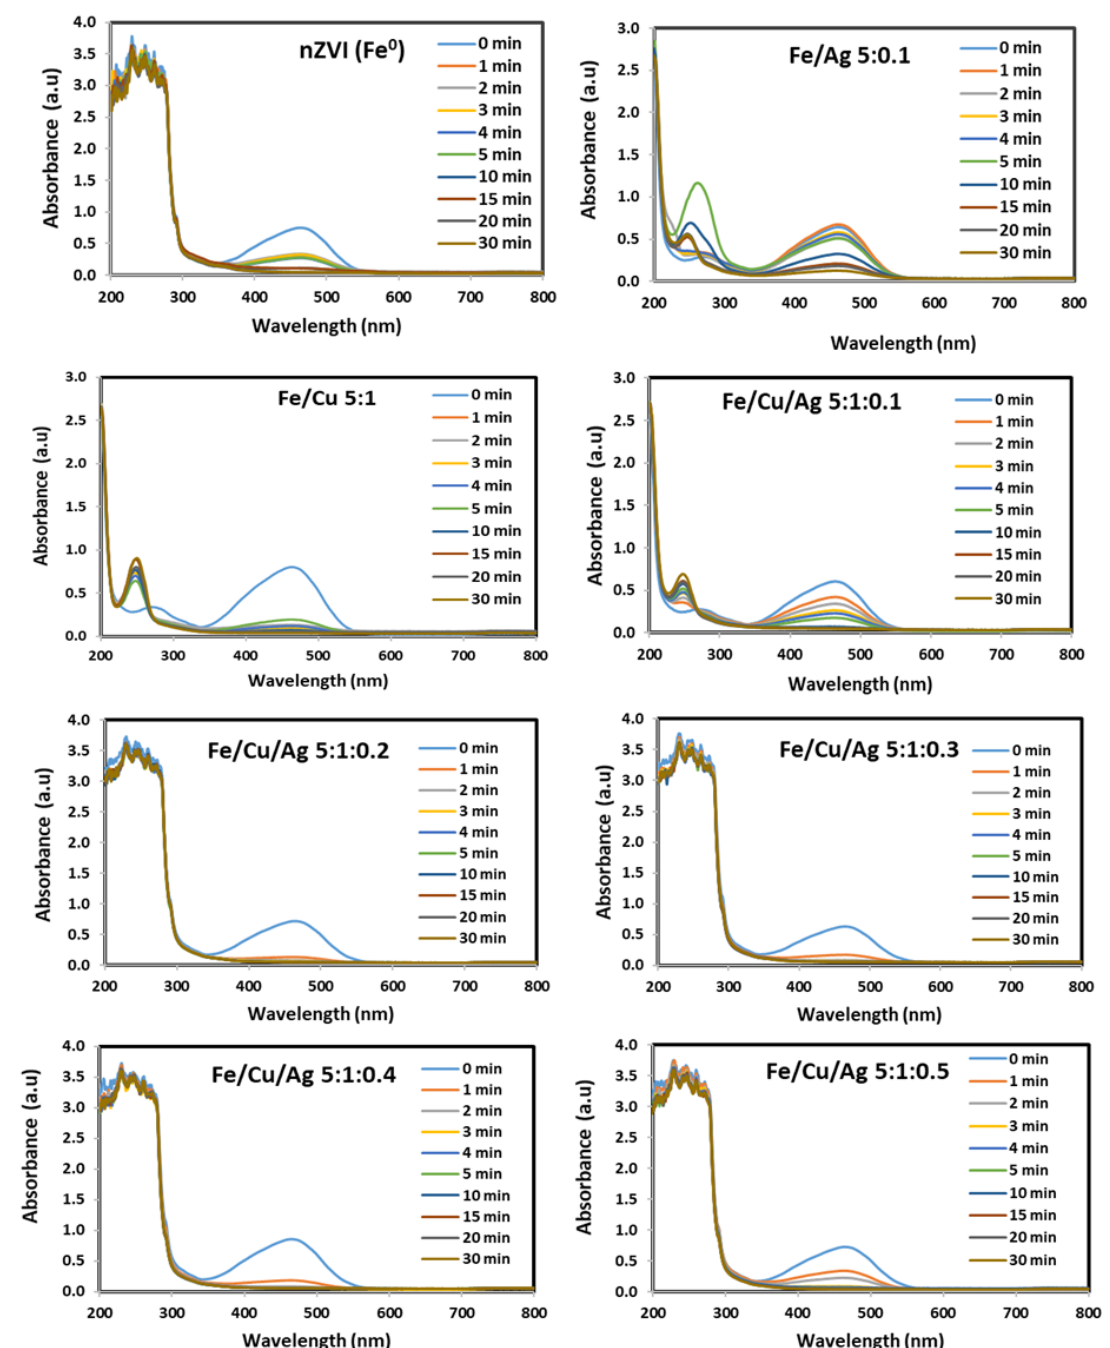
Figure A2. UV-vis absorption spectra of MO dye degradation by nZVI, bimetallic Fe/Ag (5:0.1), bimetallic Fe/Cu (5:1) and trimetallic Fe/Cu/Ag (5:1:0.1), (5:1:0.2), (5:1:0.3), (5:1:0.4) and (5:1:0.5) nanoparticles for 30 min.